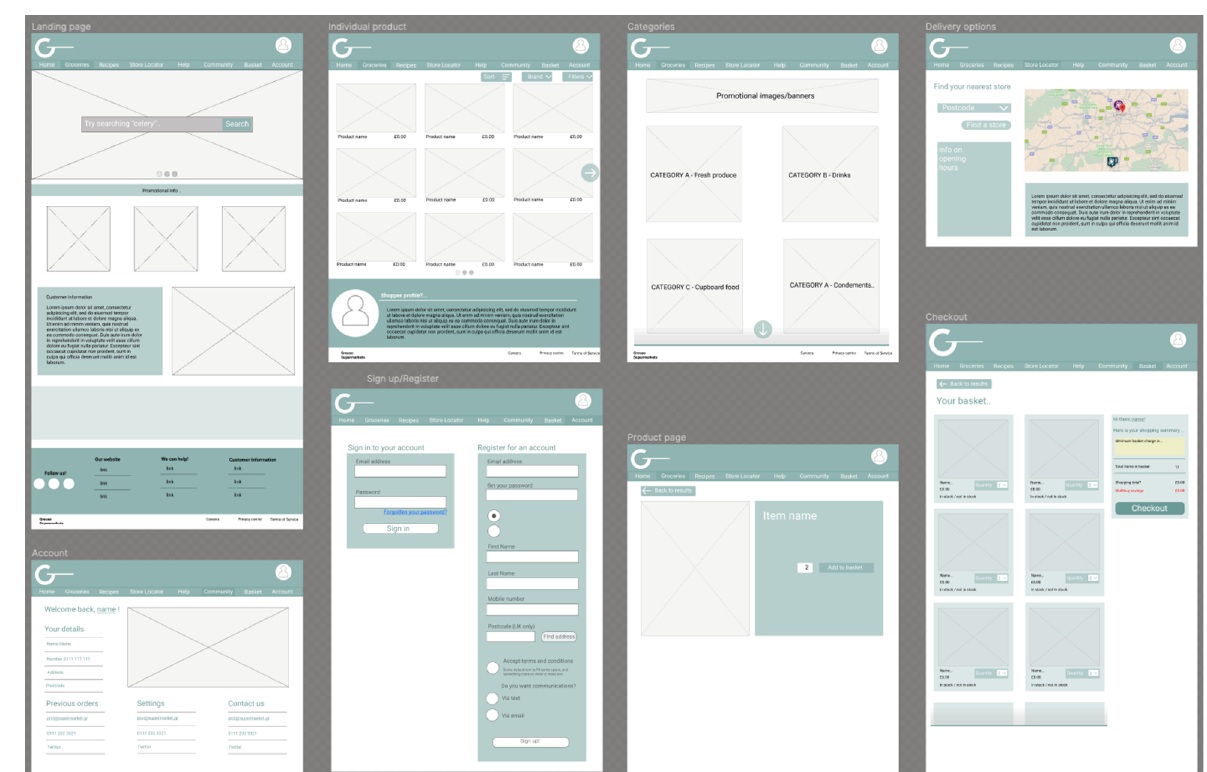
Figure 3. Low Fidelity Wireframes of the Supermarket website.